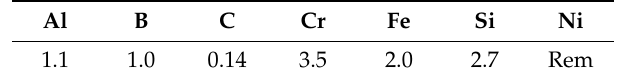
Table 2. Chemical composition of cladding materials (mass fraction